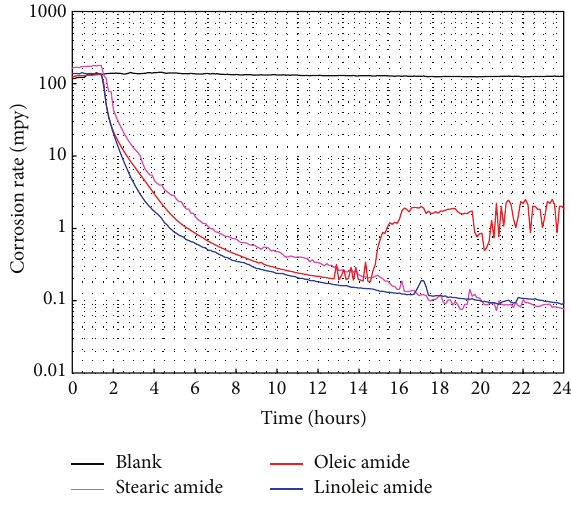
Figure 14: Variations of corrosion rate as determined by LPR measurements ( monitoring real-time ) with time for 1018 carbon steel exposed to CO 2 -saturated (3% NaCl + diesel) emulsion at 50 ∘ C, with